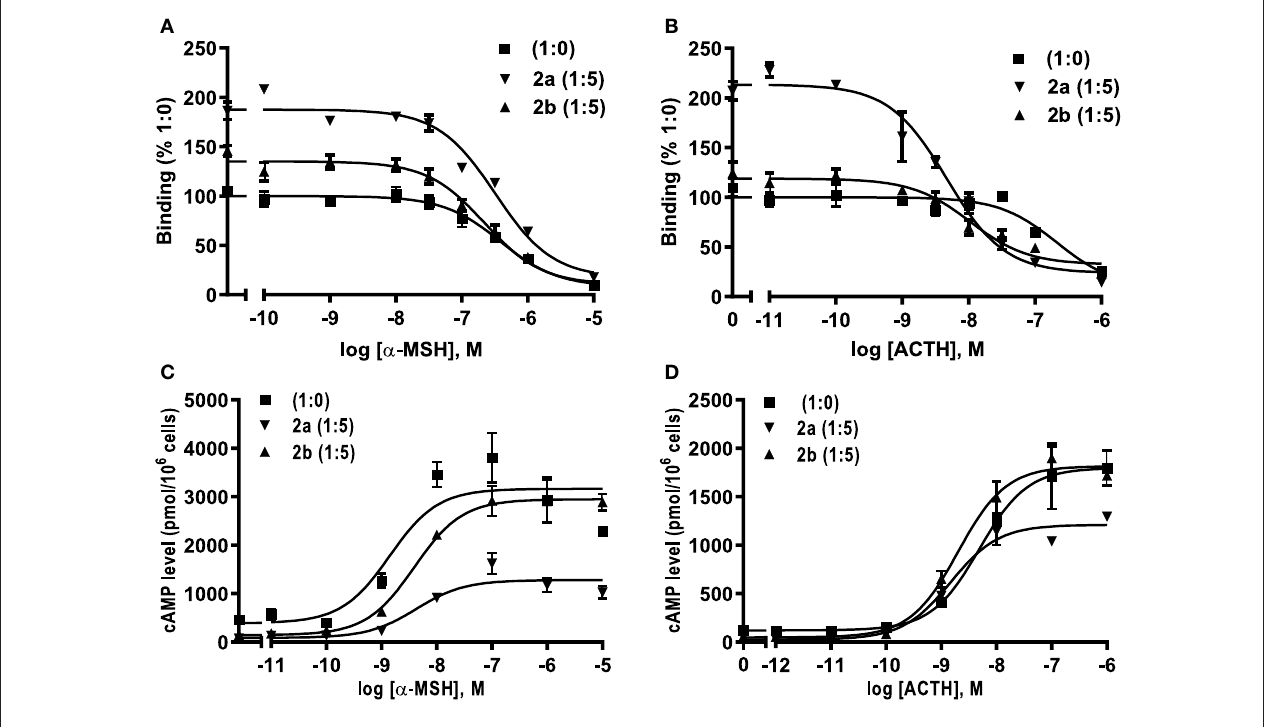
FIGURE 8 | Modulation of caMC4R pharmacology by caMRAP2a or caMRAP2b. Binding (A,B) and signaling properties (C,D) of caMC4R to α -MSH or ACTH (1–24) upon co-expression of caMRAP2a or caMRAP2b were measured. HEK293T cells were co-transfected with caMC4R/caMRAP2a or caMC4R/caMRAP2b in two different ratios (1:0, and 1:5). Binding and signaling properties were calculated as described in detail in Figures 4 , 5 , respectively.